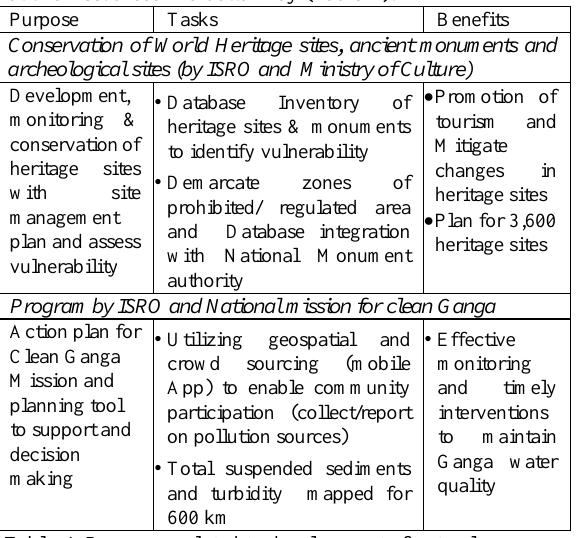
Table-4. Programs related to development of natural resources Programs linked with citizen services are oriented towards identifying gap areas and providing ease of service (Table-5). Recent thrust towards digital India and digital economy has surged the demand of satellite internet services Fig-1: Bhuvan MNREGA Application